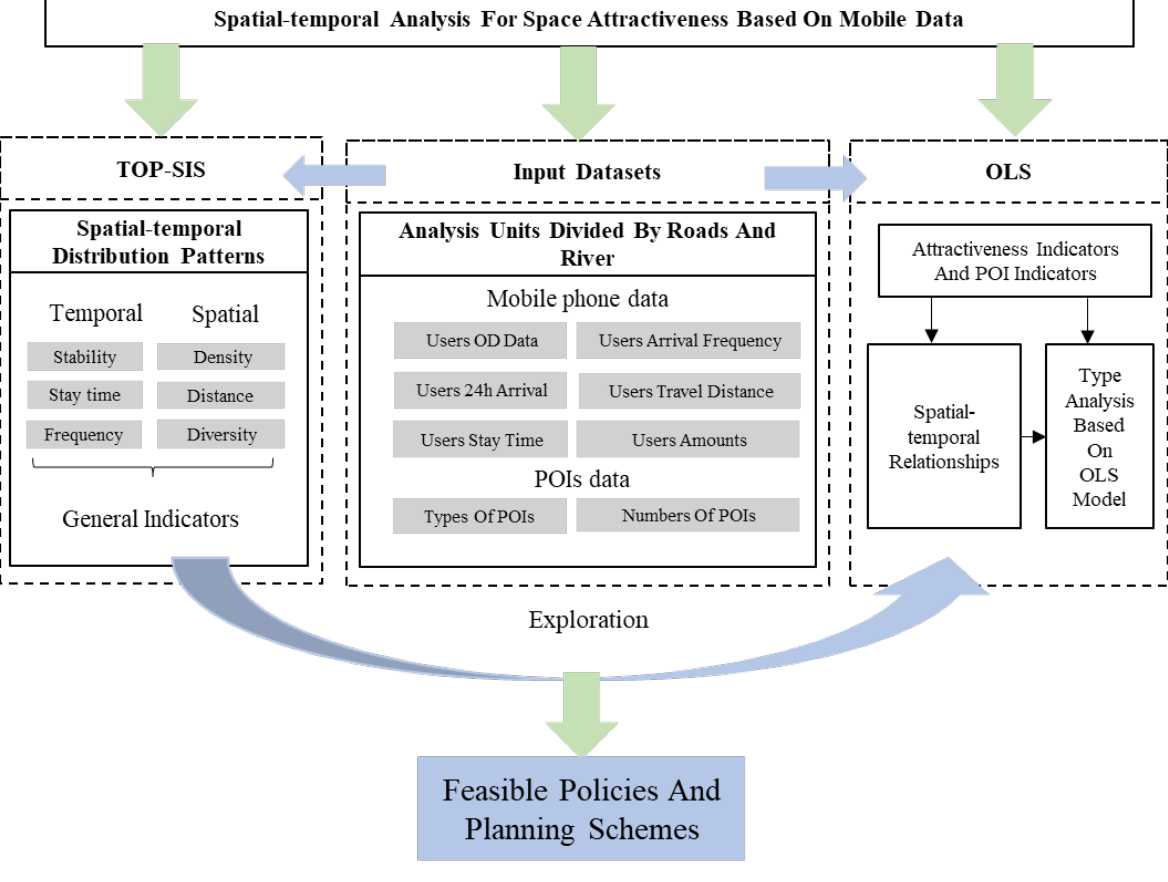
Figure 3. The research framework.